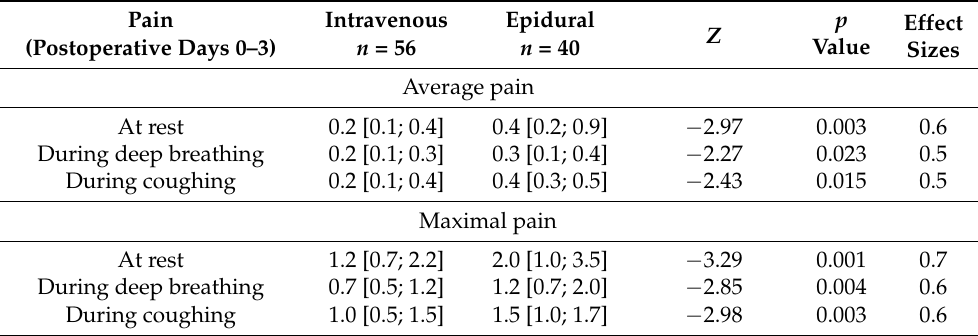
Table 3. Average and maximal postoperative pain in the intravenous and epidural